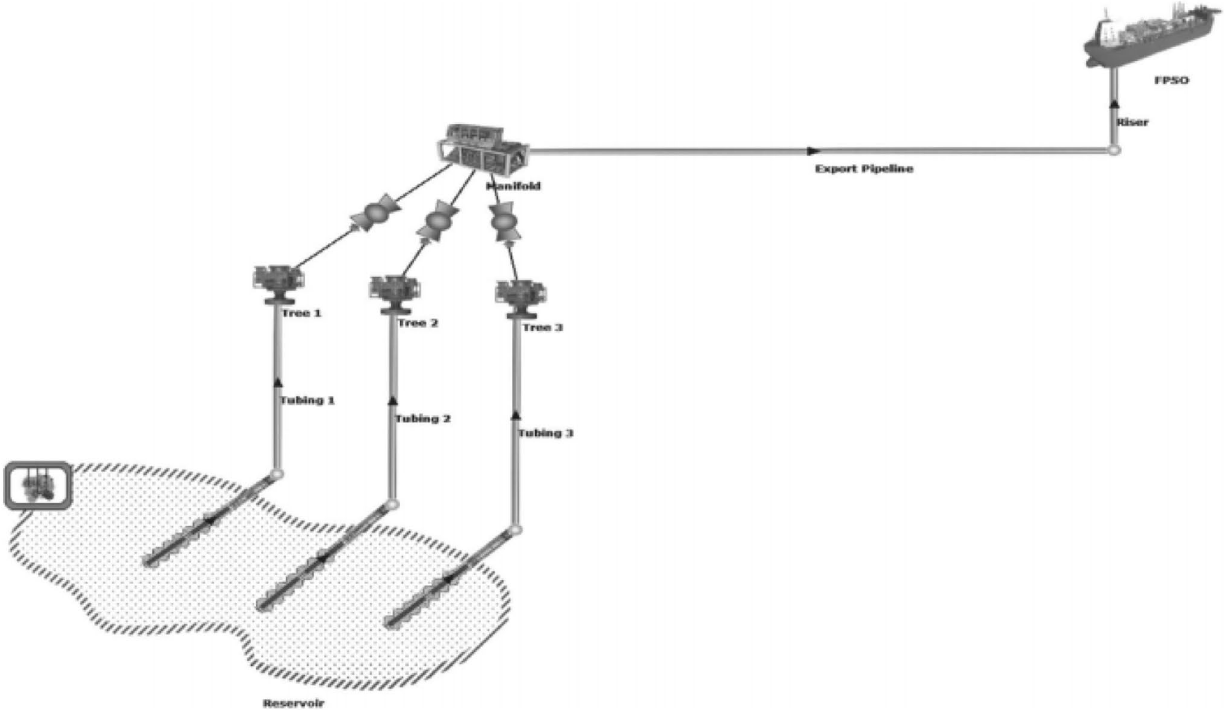
Fig. 3 Example model: three-well oil production system (Watson et al.